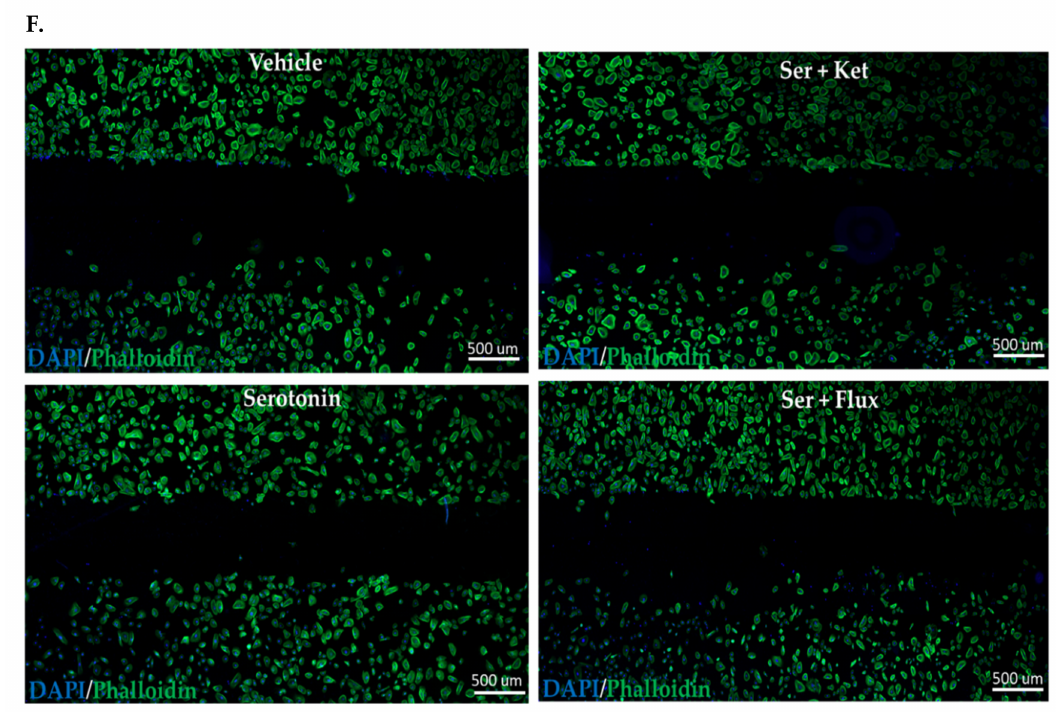
Figure 2. Comparative cellular effects of serotonin, ketanserin and fluoxetine drug treatments on cell migration, in human fibroblasts and neonatal keratinocytes cultures. ( A ) Migrating fibroblasts narrowed the scratch zone and width of scratch zone was measured in micrometers ( µ m) at Time 18 h. ( B ) Migrated fibroblast’s count in scratch zone from Time 0 h. to Time 18 h. ( D ) Migrating keratinocytes decreased the scratch width and measured in micrometers ( µ m) at Time 30 h. ( E ) Migrated keratinocyte’s count in the scratch zone from Time 0 h to Time 30 h. ( C , F ) Migration assay: immunofluorescence staining with DAPI and Phalloidin. The scale bar shown in micrometers ( µ m) at the bottom of each image. Graphical results were presented as mean ± Standard Deviation (SD), (* p < 0.05, ** p < 0.01), n =